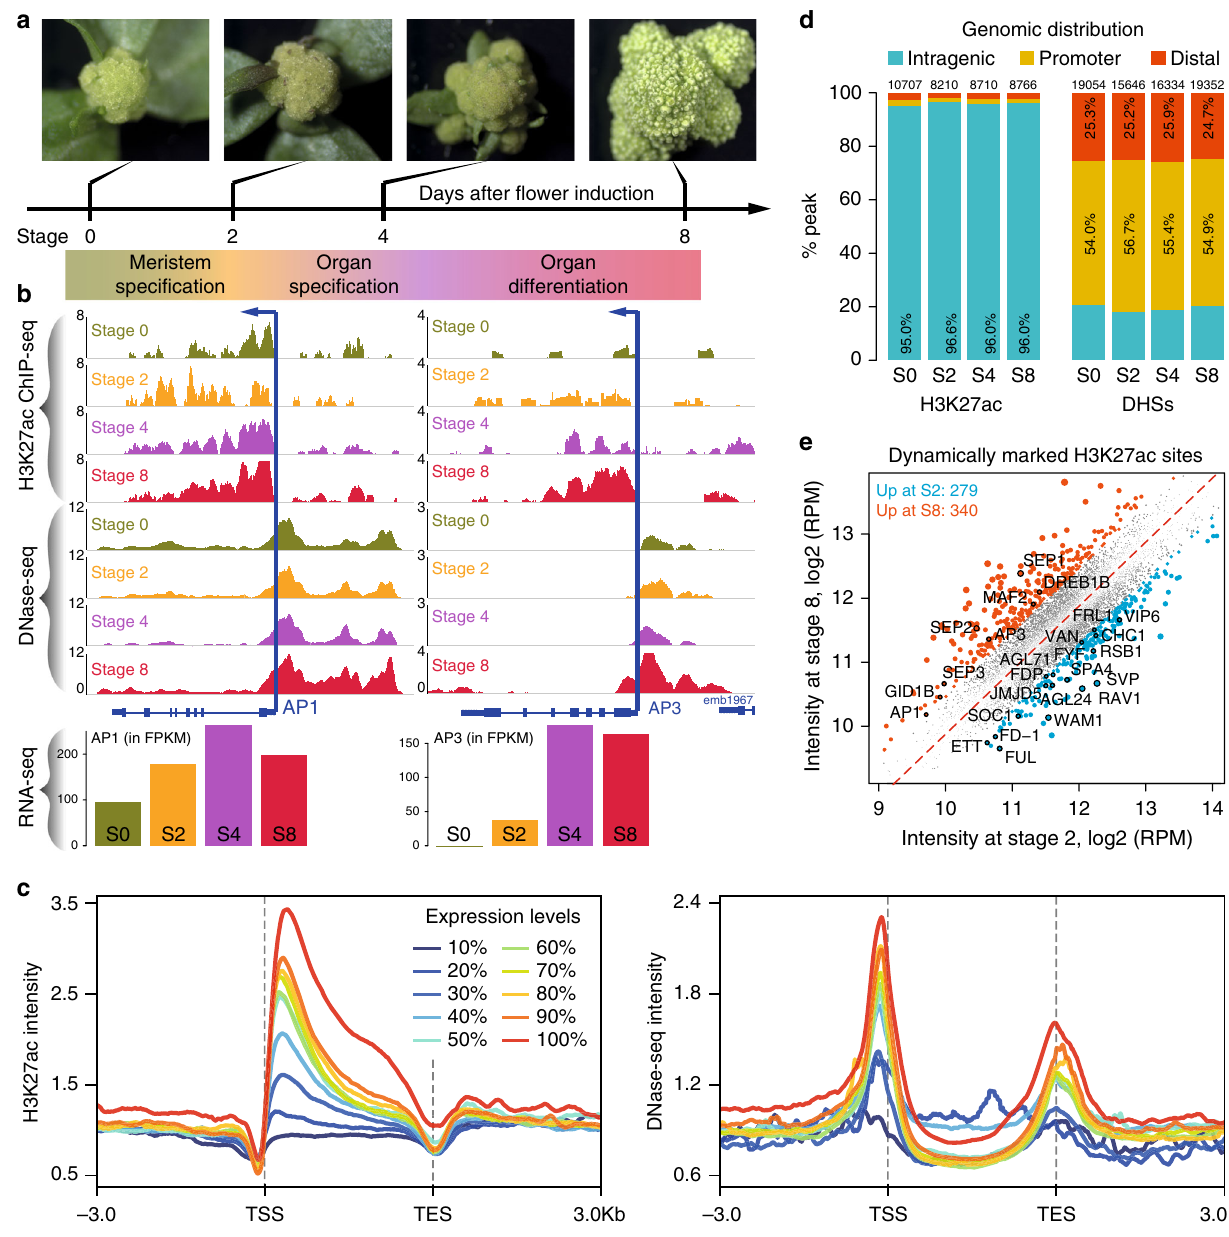
Fig. 1 Genome-wide mapping of DHSs and H3K27ac sites across fl ower development. a Schematic representation of the fl oral induction system (pAP1:: AP1-GR ap1 cal ) for collecting synchronized fl ower tissues at four key developmental stages (stage 0, stage 2, stage 4, and stage 7/8). b Genome browser tracks (colored according to stages) showing H3K27ac binding signal (measured by ChIP-seq) and chromatin accessibility (by DNase-seq) around the AP1 (left) and AP3 (right) loci. The expression levels of these two genes measured by RNA-seq are shown in the barcharts below. FPKM, fragments per kilobase of transcript per million mapped reads. S0, stage 0. c The relationship between H3K27ac binding signals (left) or chromatin accessibility (right) and the levels of gene expression at stage 8. In the analysis, the expressed genes were equally divided into 10 groups ( n = 2083 genes in each group) from low expression (10%) to high expression (100%) based on the expression levels. Mean-normalized ChIP-seq or DNase-seq densities were plotted within a 6- kb region fl anking the transcription start site (TSS) or the transcription end site (TES) for each groups of genes. d Stacked bar plot showing the distribution of H3K27ac peaks and DNase I hypersensitive sites (DHSs) in different genomic regions at 0, 2, 4, and 8 DAI. Promoters are de fi ned as genomic regions encompassing 1 kb upstream of the TSS. Distal intergenic regions are genomic regions except intragenic and promoter regions. Peaks were assigned to each category based on their summits. e Comparison of H3K27ac enrichment at stages 2 and 8 of fl ower development. Each point represents an H3K27ac enriched region. Regions showing more than 1.5-fold difference of enrichment are indicated in blue (more enrichment at S2) and red (more enrichment at S8). Numbers indicate the number of target genes. Examples of target genes (with black circles) are labeled. The underlying source data for d and e